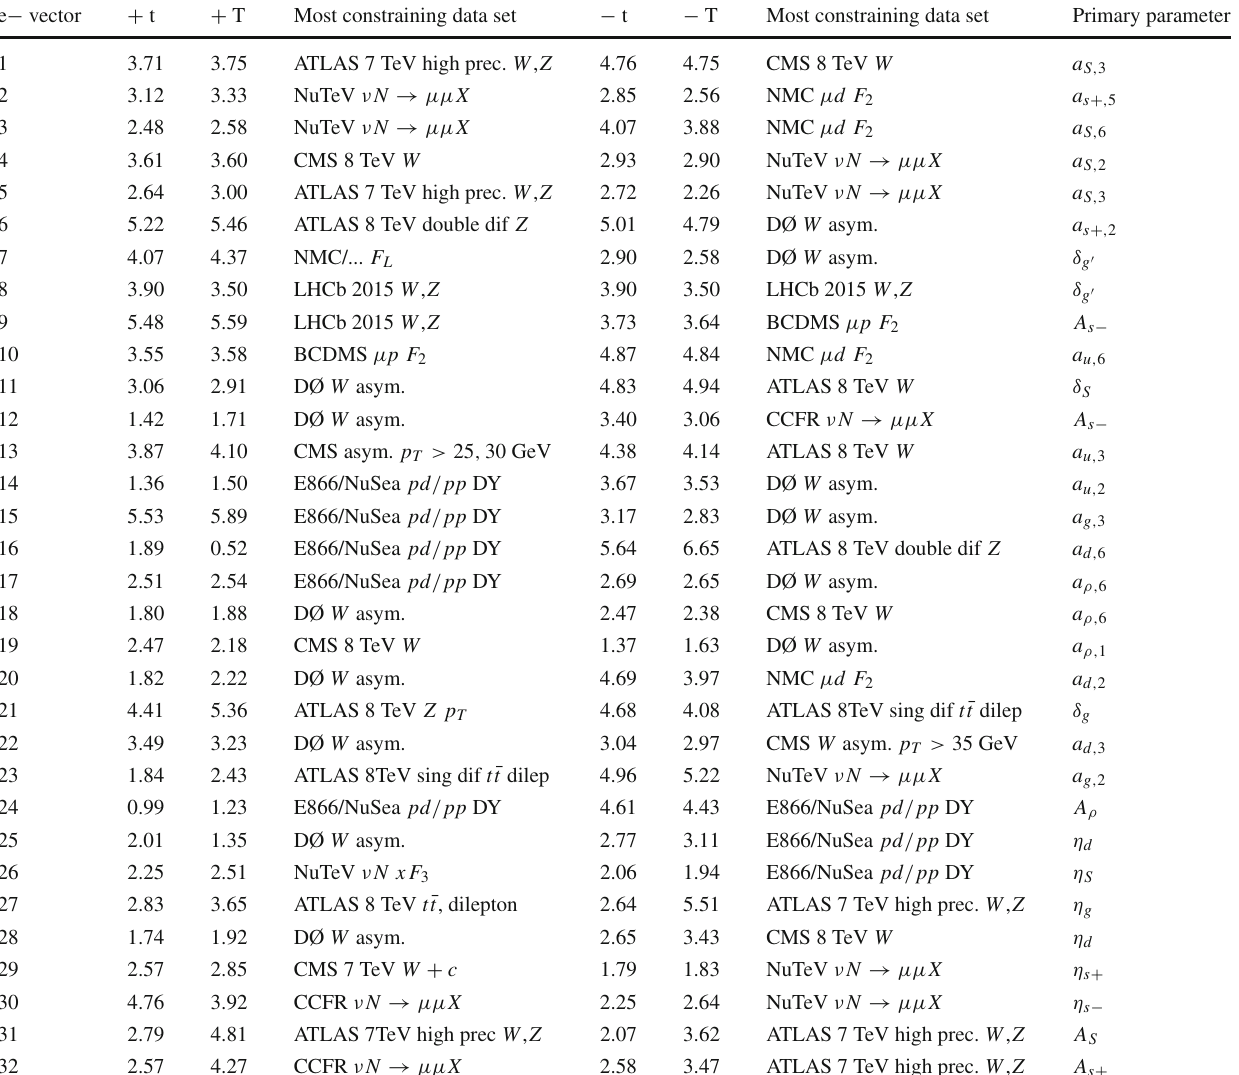
Table 10 The NNLO eigenvectors (in both directions) for the default ) = 0 . 118 global fit, including the tolerances for each MSHT20 α S ( M 2 Z eigenvector, the data set which most constrains that eigenvector in each